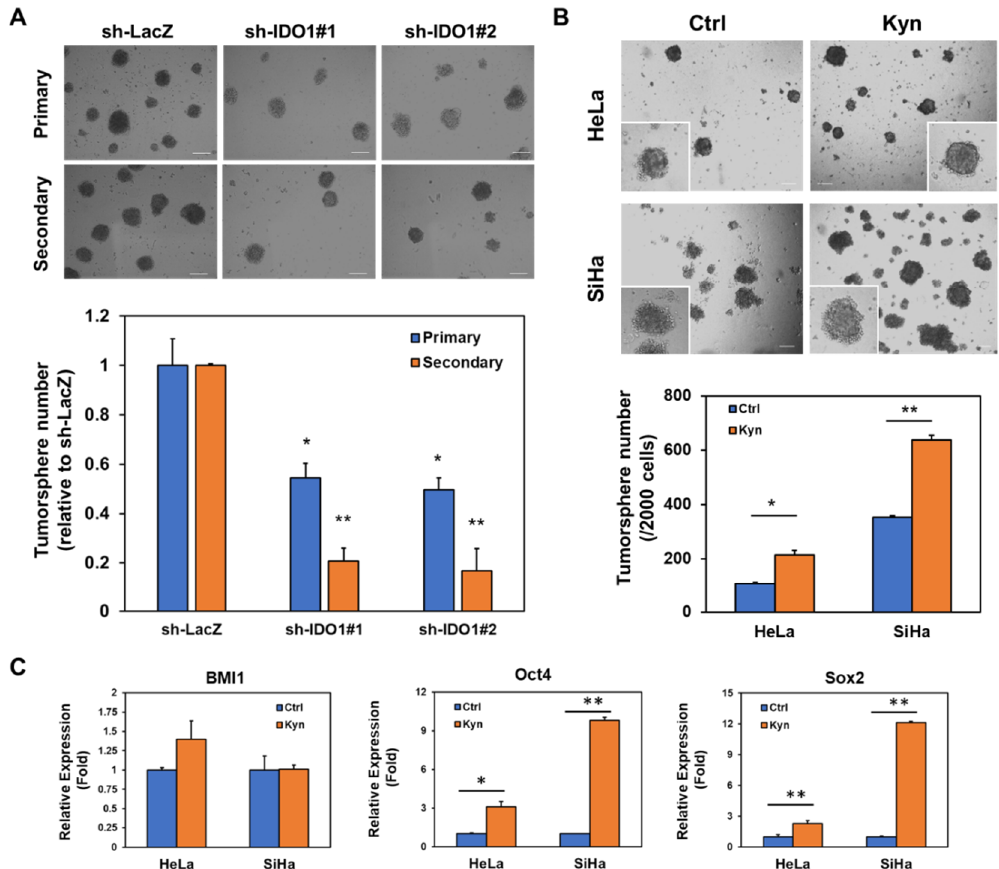
Figure 7. Tryptophan metabolism by IDO1 positively regulates self-renewal of cervical CSCs. ( A ) SiHa cells were transduced with lentiviruses carrying IDO1 specific shRNAs (IDO1#1 or IDO1#2) or control LacZ specific shRNA (LacZ) followed by selection with puromycin. The surviving cells were collected at 48 h and 2 × 10 3 cells were used to perform primary tumorsphere cultivation and the tumorsphere numbers were counted at day 7, followed by collecting formed primary tumorspheres with 100 µ m cell strainer. The collected primary tumorspheres were dissociated into single cells and 1 × 10 3 cells were used for secondary tumorsphere formation followed by counting the tumorsphere number at day 7. * p < 0.05; ** p < 0.01 when compared to sh-LacZ group. ( B , C ) HeLa and SiHa cells were performed tumorsphere cultivation in the supplement of 100 µ M kynurenine. The tumorsphere numbers were counted at day 7. The total RNA was collected at 48 h after kynurenine treatment and the expression of BMI1, Oct4 or Sox2 were determined by qRT-PCR method. * p < 0.05; ** p < 0.01. All the experiments were repeated three times and data from one experiment were presented.